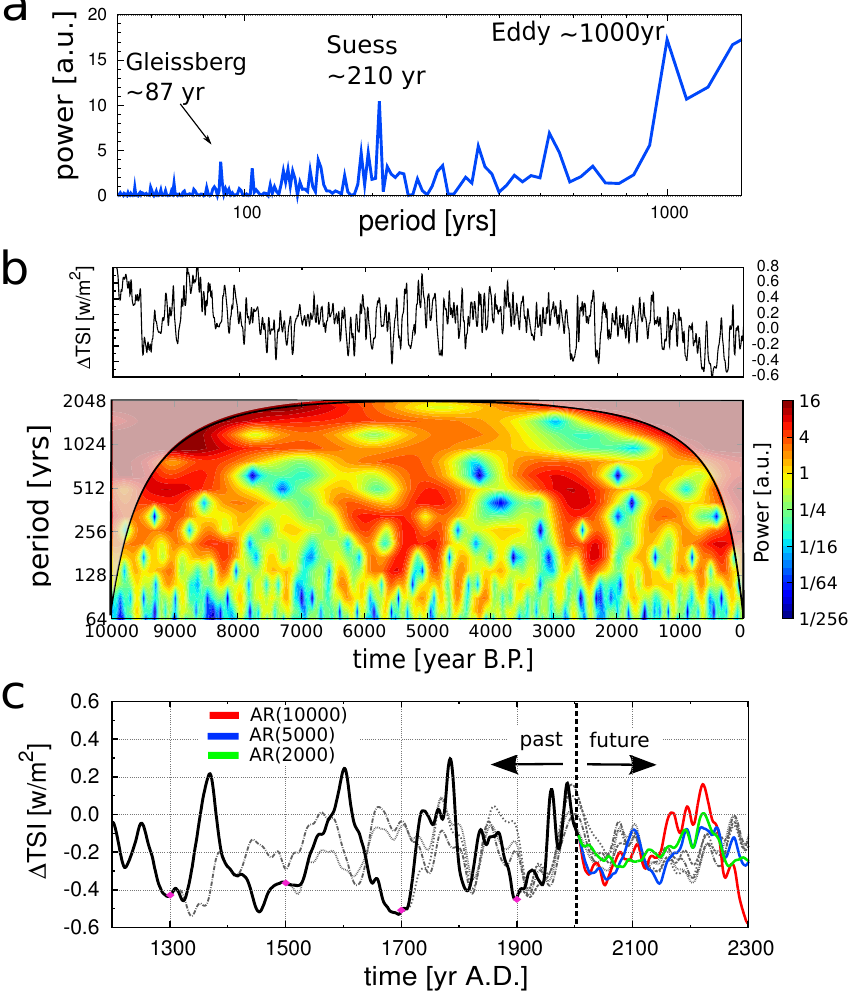
Fig. 15. (a) Power spectrum of our TSI record up to periodicities of 2000yr. The most dominant periodicities correspond to the Gleissberg, Suess and Eddy cycles. (b) Wavelet power spectrum calculated with a Morlet wavelet with log 2 periodicity axis and colour shading. (c) Fore- casting of the solar irradiance using an autoregressive model of order p (AR( p )) fitted using Burg’s method. Before fitting the time series, a high-pass filter (1000yr) has been applied in order to remove low-frequency trends. The dashed lines show forecasts with the AR(5000) model starting at year 1300, 1500, 1700 and 1900AD (magenta dots). Coloured lines show forecasts starting in 2005AD for different orders of the AR